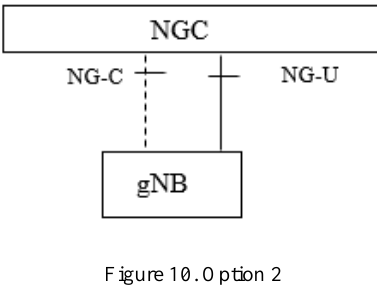
Figure 10. Option